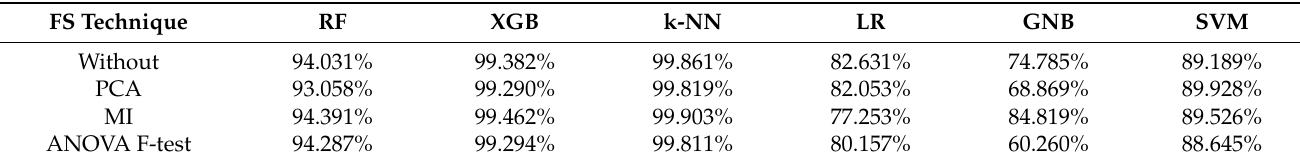
Table 7. Exploration Investigation: Accuracy of ML models.